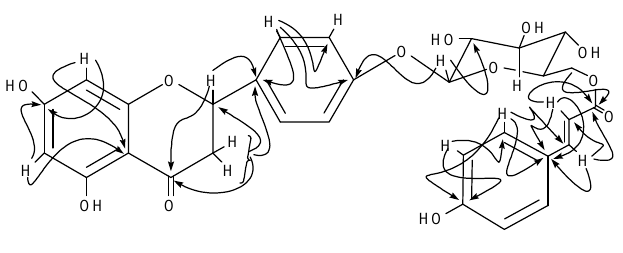
Figure 2. Important HMBC correlations of 1